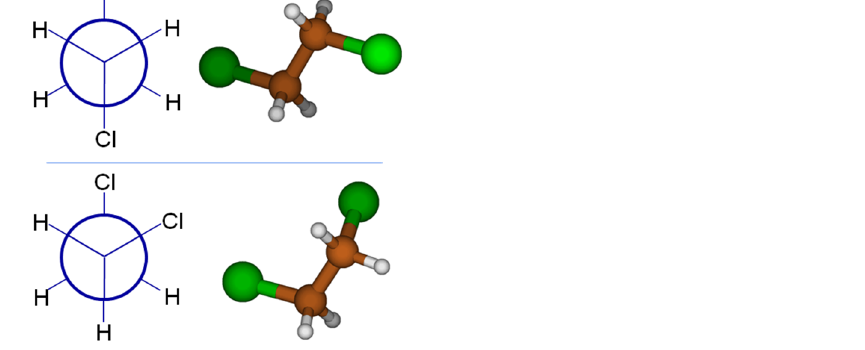
Figure 1. 1,2-Dichloroethane in the ( top panel ) anti and (bottom panel ) gauche